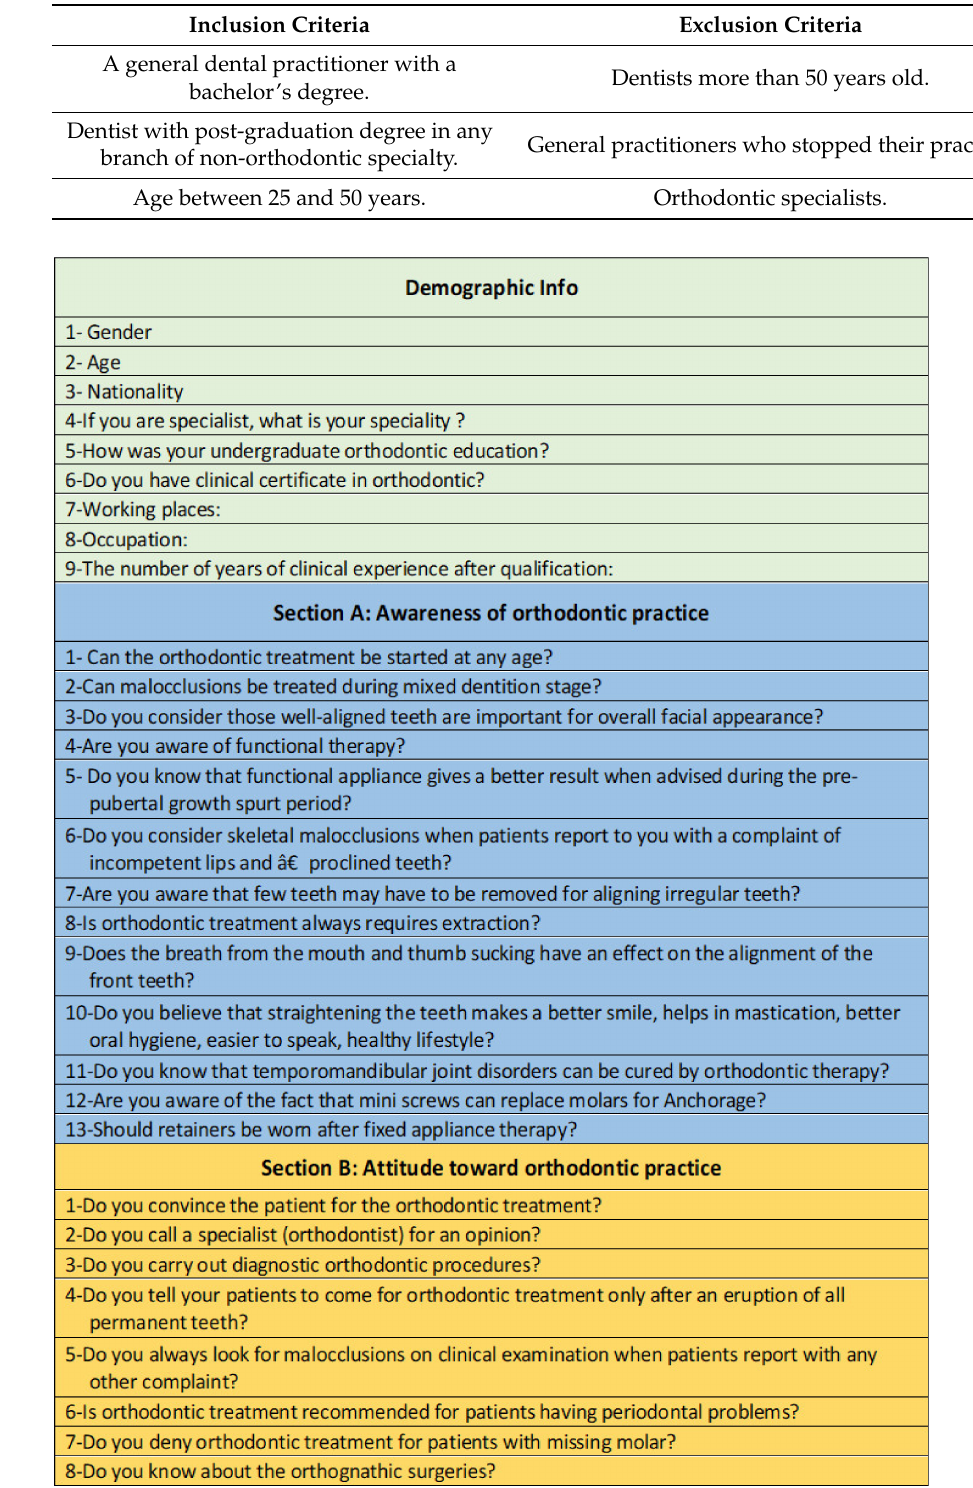
Figure 1. Sample